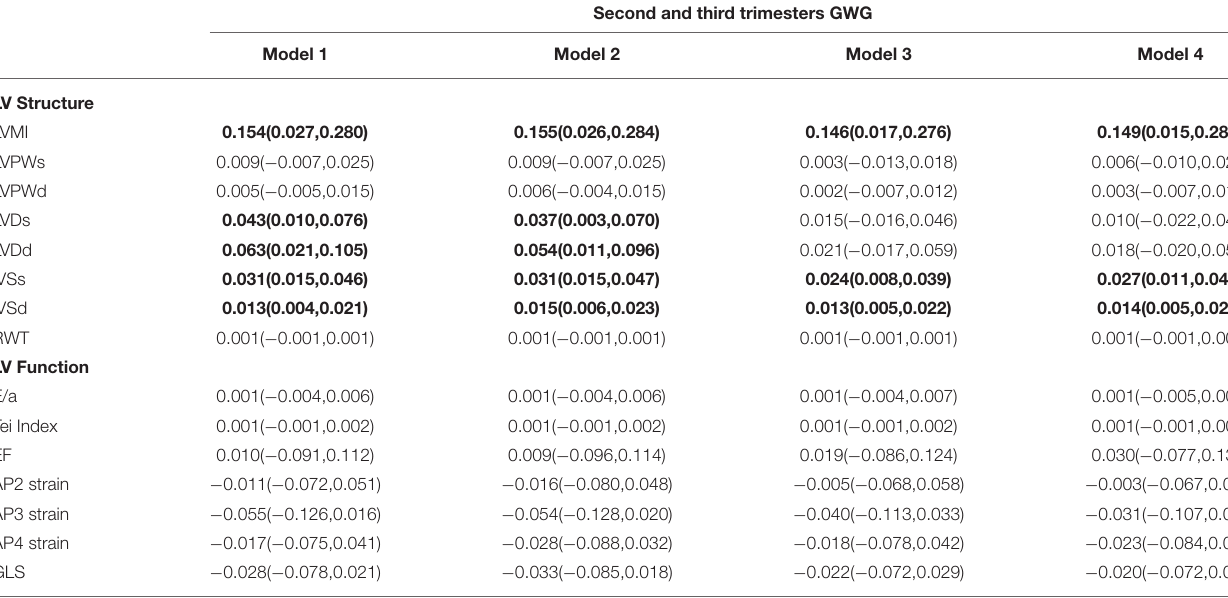
TABLE 3 | Association between maternal GWG and offspring LV geometry and function in the second and third